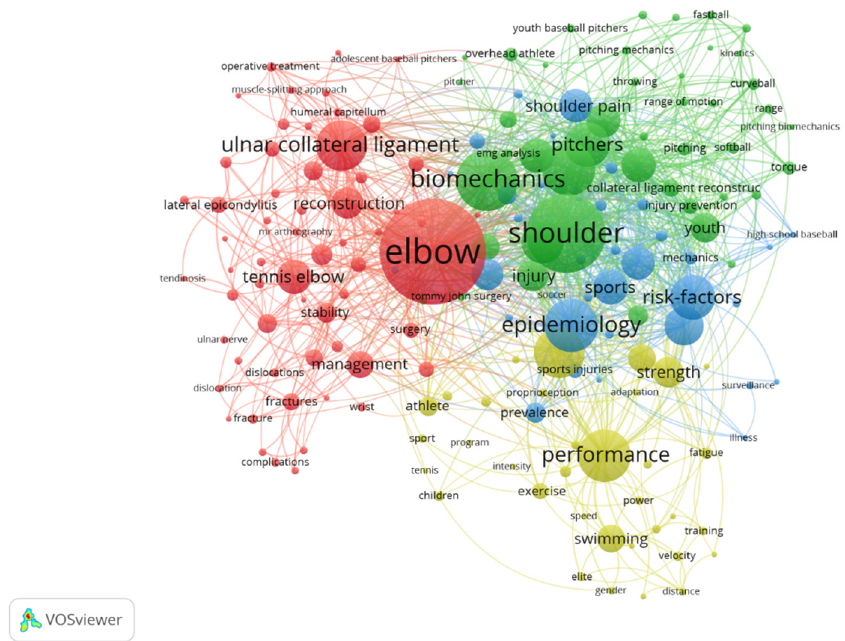
Figure 3. Analysis of the keywords in publications on elbow pain: co-occurrence of keywords. The size of nodes indicates the frequency of occurrence. The curves between the nodes represent their co-occurrence in the same publication. The shorter the distance between two nodes, the larger the number of co-occurrences of the two keywords.